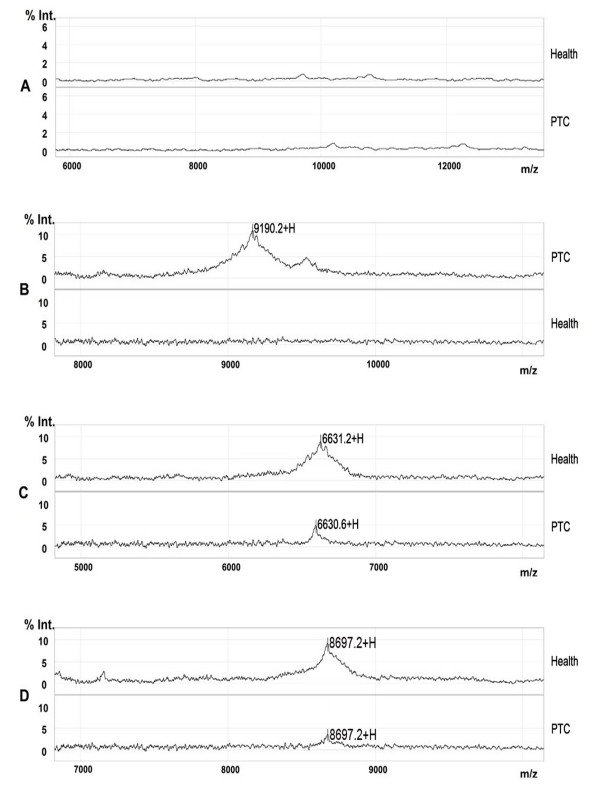
Representative spectra from ProteinChip array with specific immobilized antibodies. (A) Representative spectra of the negative control (nonspecific rabbit IgG). (B) Representative spectra from ProteinChip array with anti-haptoglobin alpha chain antibody. (C) Representative spectra from ProteinChip array with anti-apolipoprotein C-I. (D) Representative spectra from ProteinChip array with anti-apolipoprotein C-III.